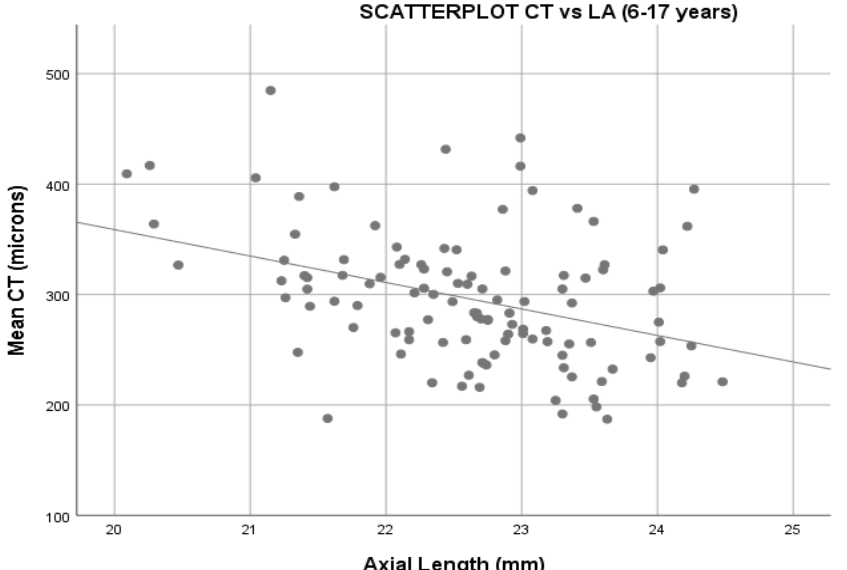
Figure 4. Scatterplot showing results for choroidal thickness and axial length in patients 6–17 years old.